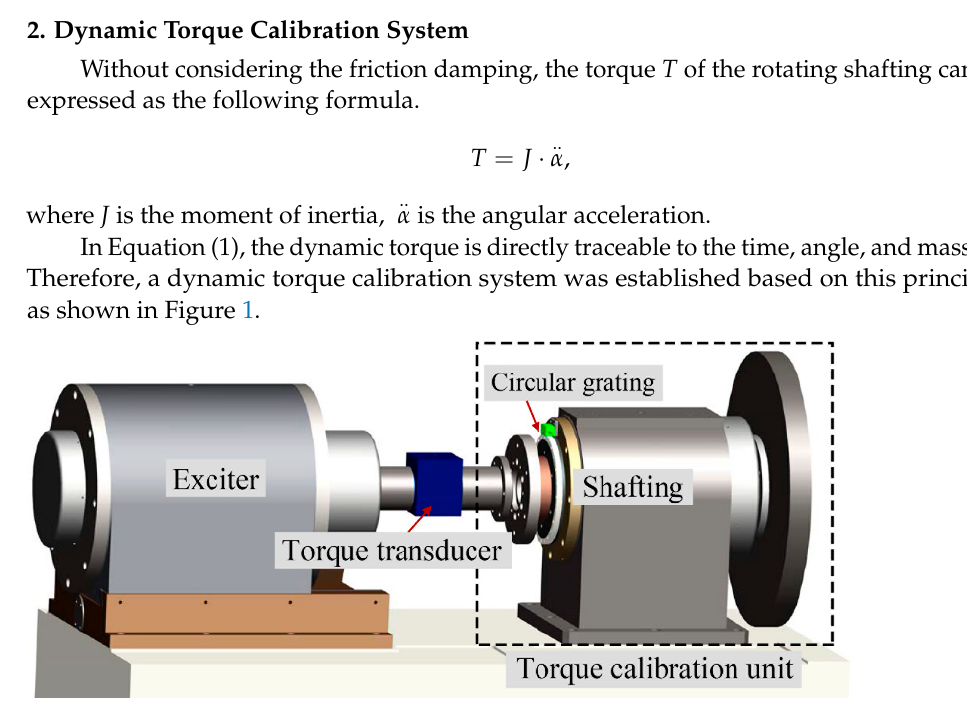
Figure 1. Schematic diagram of the dynamic torque calibration system. The dynamic torque calibration system mainly included an exciter and a torque cal- ibration unit. The calibrated torque transducer was installed between the exciter and the torque calibration unit. In order to realize the calibration of dynamic torque, we first controlled the exciter to generate a varying torque. Because there was a large error between the real value and the preset value of the torque generated by the exciter, we needed to use the torque calibration unit to accurately measure the actual dynamic torque of the shafting. During excitation, the generated torque was transferred via the torque trans- ducer onto the torque calibration unit to generate the angular acceleration of its shafting. By measuring the angular acceleration and the moment of inertia of the shafting, the dynamic torque could be accurately determined according to Equation (1) [4]. Then, the dynamic torque value measured by the dynamic torque calibration unit was compared with the value measured synchronously of the torque transducer to realize the dynamic calibration for the torque transducer. As a dynamic torque calibration system, the accurate dynamic torque value had to first be obtained before it could be compared with the measured value of the torque transducer. Therefore, it was required to accurately measure the moment of inertia J and .. α of the shafting. The moment of inertia J of the shafting of the torque angular acceleration calibration unit was constant in a single experiment and could be measured in advance by the torsional pendulum method [31]. In the calibration experiment, the rotation angle α of the shafting was dynamically measured by a circular grating. The angular acceleration .. α could be obtained by twice differentiating the measured angle α . Then, substituting J and into Equation (1), the dynamic torque could be obtained. Finally, the dynamic torque results were used to calibrate the torque transducer. In order to obtain a higher calibration accuracy, the dynamic torque calibration system was equipped with a high-precision circular grating for the angle measurement, and the error compensation was performed on the measured angle. In the following sections, the error model and compensation method of the circular grating angle measurement was discussed in